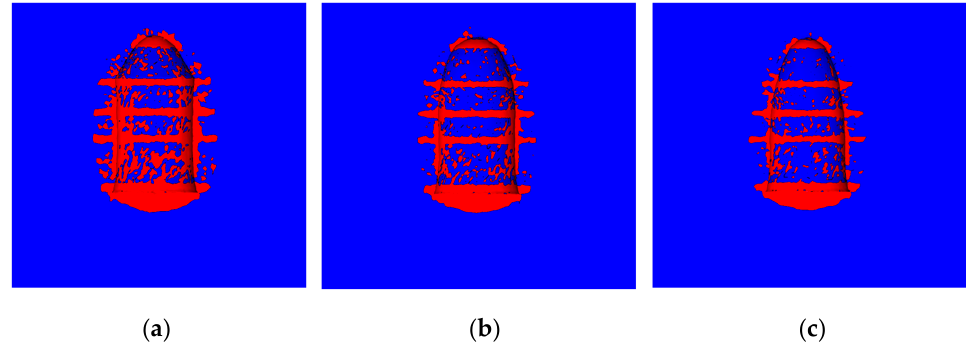
Figure 11. Plastic zone contours of the cavern with different upper shapes after operating for 30 years under the internal gas pressure of 14 MPa. ( a ) 40 m, ( b ) 70 m, ( c ) 100 m.